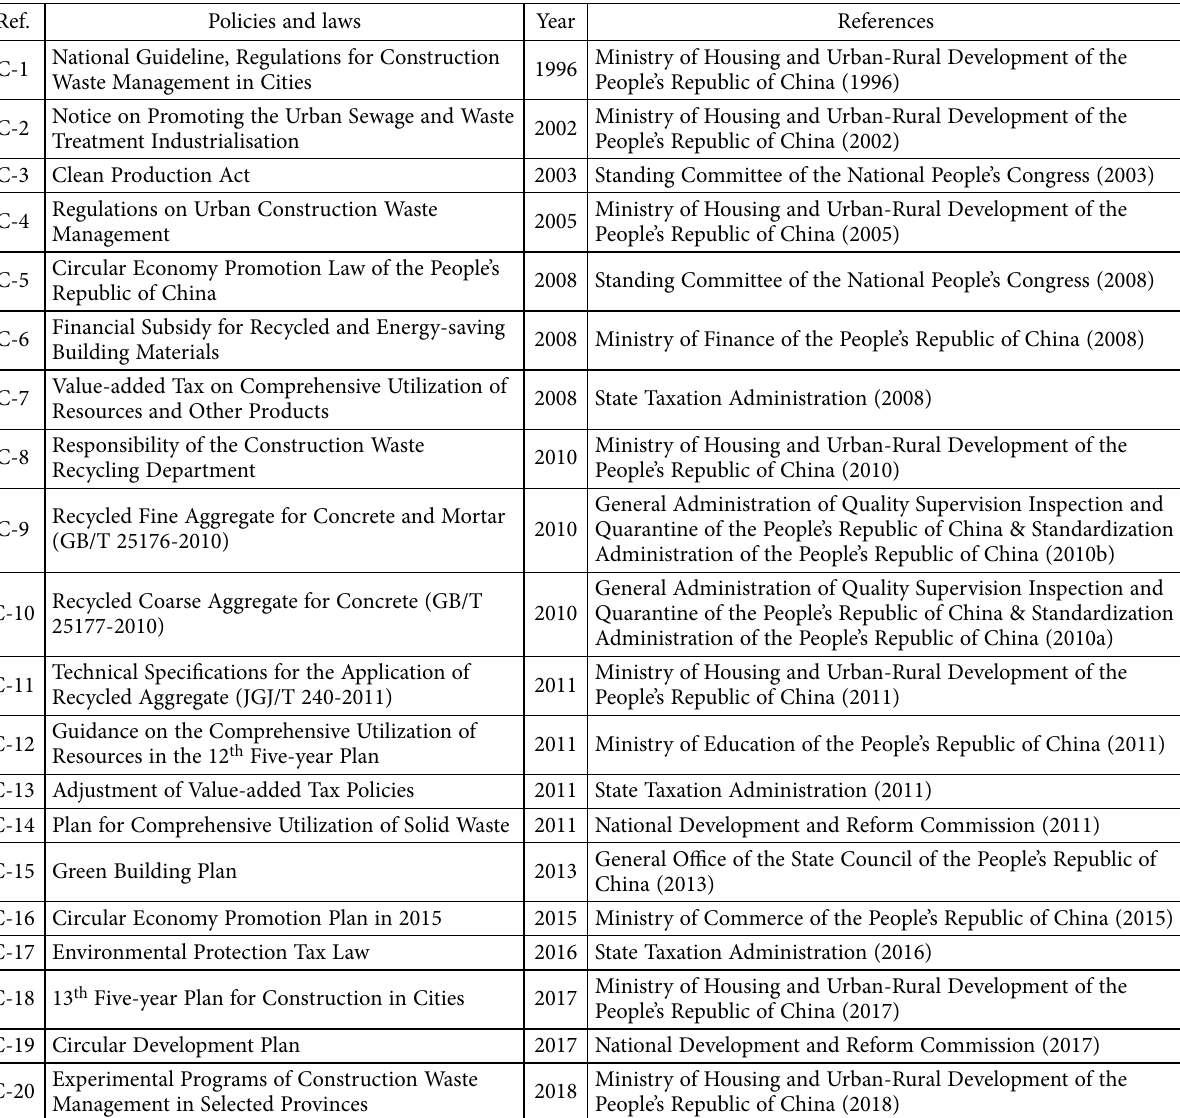
Table 3. Existing policies and laws on C&D waste management in China